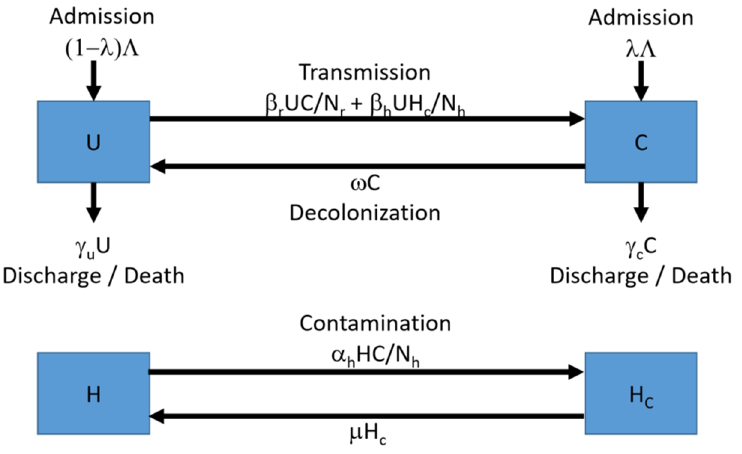
Figure 4. Schematic of the transmission model.